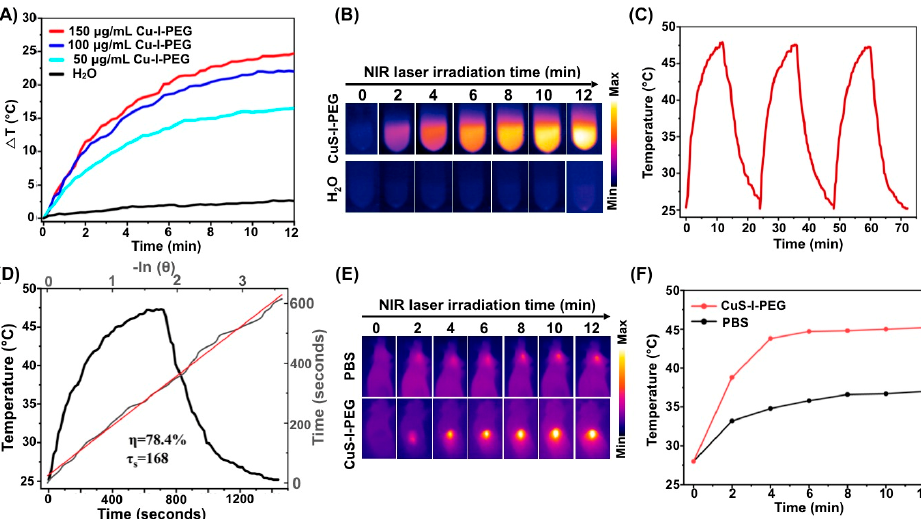
Figure 2. Photothermal conversion properties of CuS- 131 I/I-PEG nanotheranostics. ( A ) The temperature changes of CuS-I-PEG nanotheranostics under 808 nm NIR laser irradiation at a power of 2.8 W/cm 2 . ( B ) Photothermal conversion images of ( A ). ( C ) Photothermal stability of CuS-I-PEG nanotheranostics upon 808 nm laser on/off for three cycles at a power of 2.8 W/cm 2 . ( D ) Photothermal heating/cooling curve (in black) of CuS-I-PEG nanotheranostics in PBS under 808 nm NIR laser irradiation at a power of 2.8 W/cm 2 , and (gray line) liner time data versus − ln ( θ ) obtained from the cooling period of black line. Red line represented the fitting result of gray line. ( E ) Photothermal conversion images of CuS-I-PEG nanotheranostics in tumor tissues on mice under 808 nm NIR laser irradiation at a power of 2.8 W/cm 2 . ( F ) Temperature changes of CuS-I-PEG nanotheranostics corresponding to ( E ).